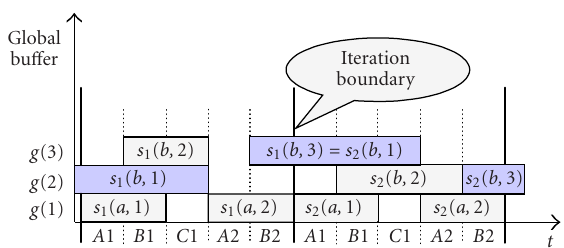
Figure 8: The global bu ff er lifetime chart spanning two iteration cycles for the example of Figure